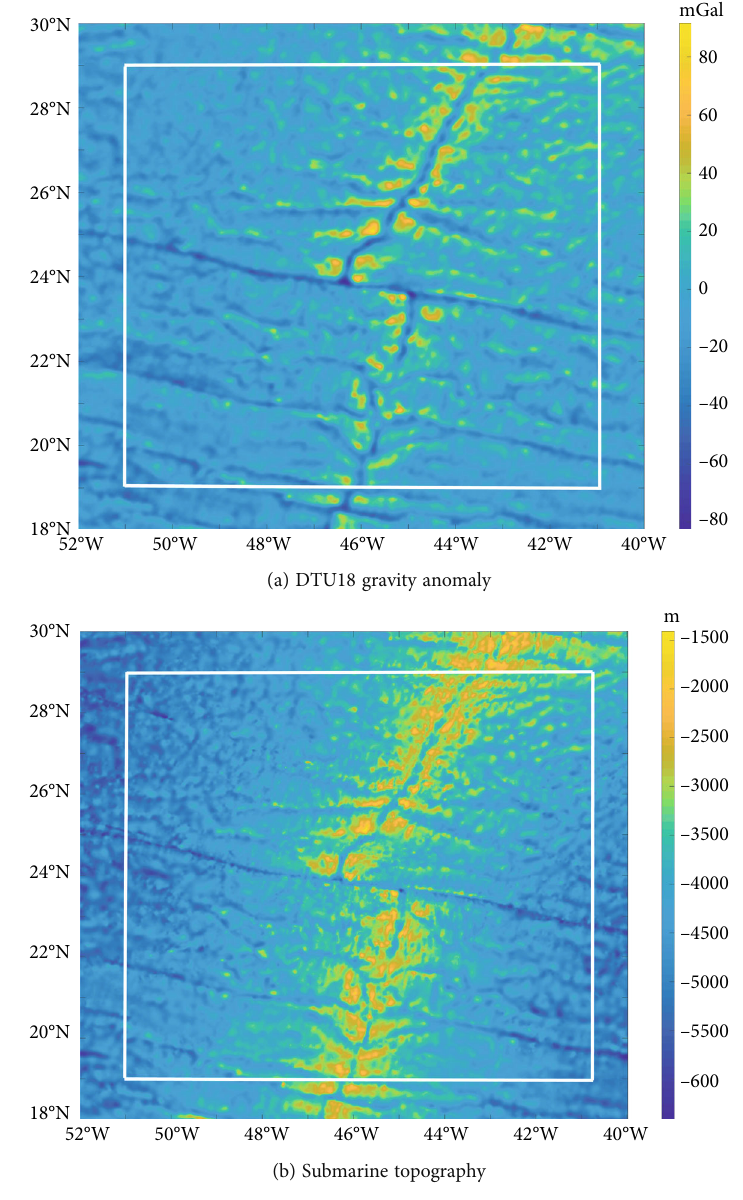
Figure 11: Physical characteristic map of the calculation area. Table 7: Accuracy analysis of performing parallel computing using di ff erent data types, where RMS indicates the root mean square.